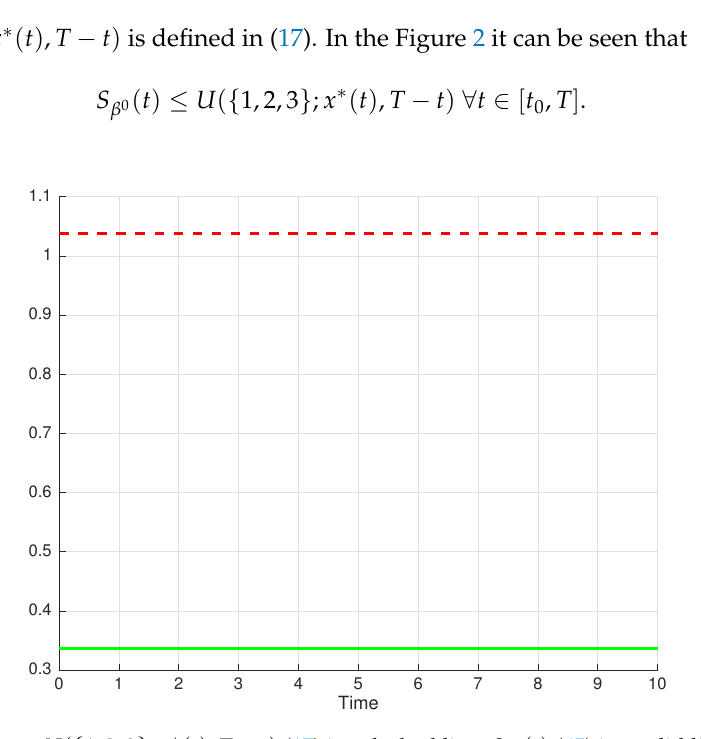
Figure 2. U ( { 1,2,3 } ; x ∗ ( t ) , T − t ) (17) is a dashed line, S β 0 ( t ) (65) is a solid